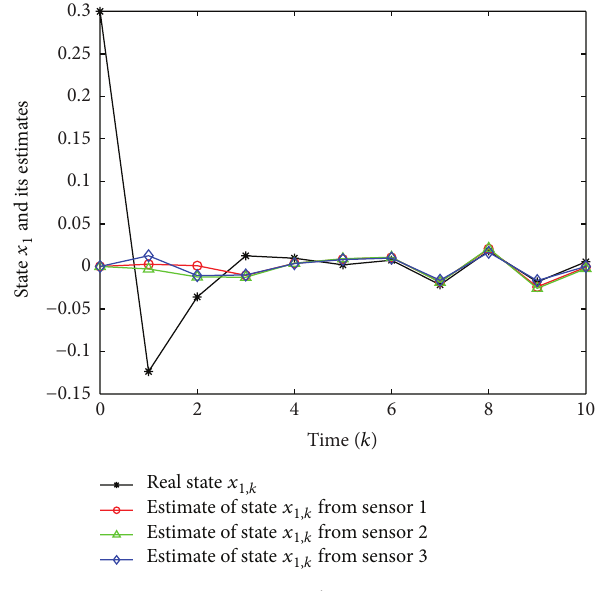
Figure 1: The state 𝑥 1 𝑘 and its estimate.